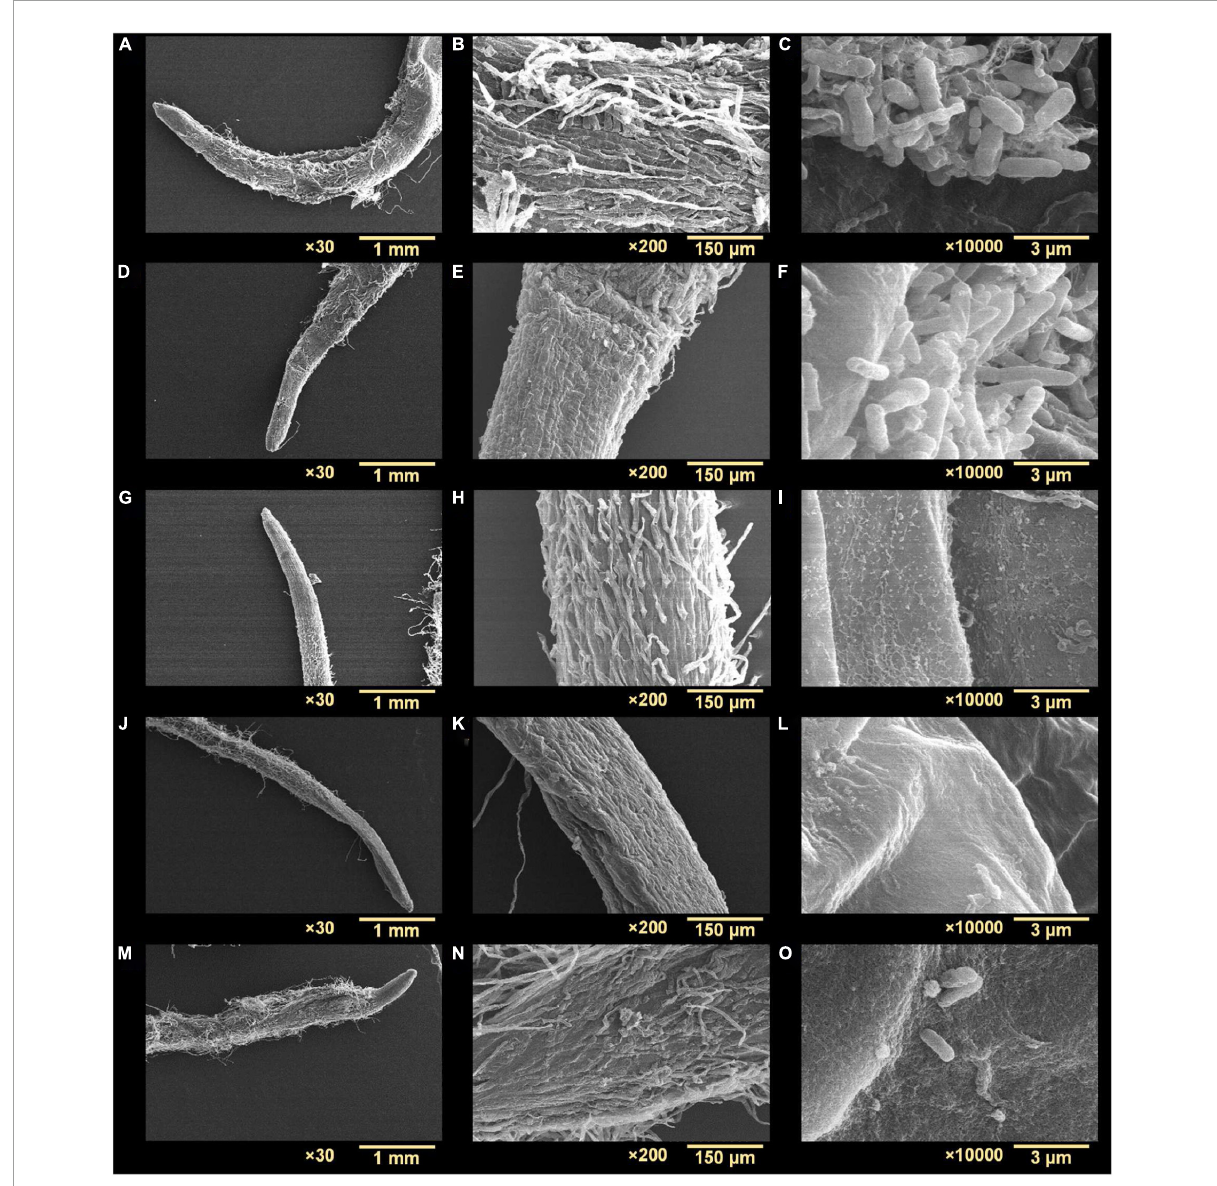
FIGURE7 Scanning electron microscopy micrographs of A. tumefaciens biofilms on the surface of R. sativus at three different magnifications (30 × , 200 × , and 10,000 × ): non-treated (A–C) , treated with t -CNMA (D–F) , 4-nitro CNMA (G–I) , 4-chloro CNMA (J–L) , and 4-fluoro CNMA (M–O)